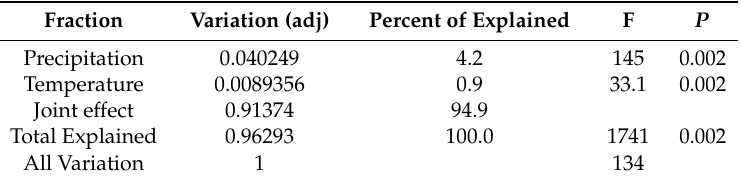
Table 2. RDA Results for EMD residuals at regional